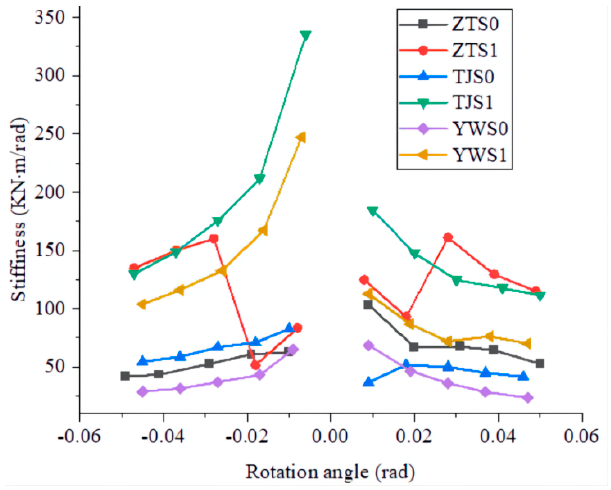
Figure 11. Stiffness - degradation curve of each joint sample.